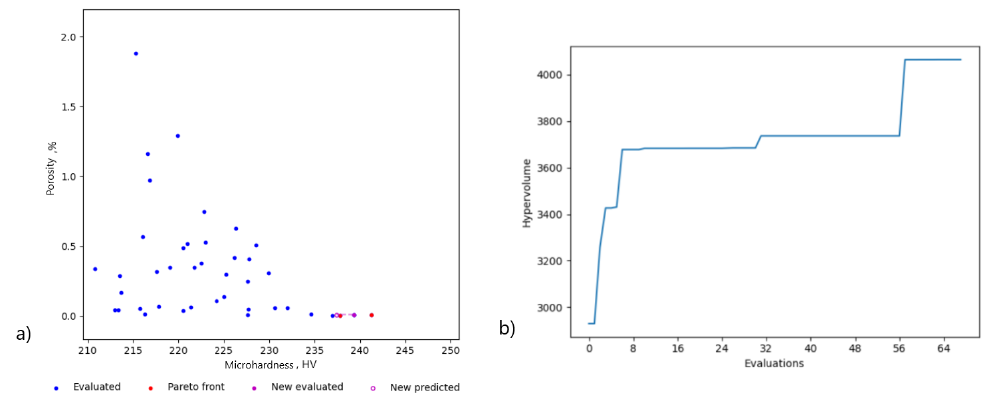
Figure 5. Performance results. ( a ) The scatter plot of the hardness versus porosity (Pareto front is colored red); open magenta marks represent candidate configuration, and solid magenta marks denote the suggested configuration after evaluation. ( b ) The hypervolume improvement plot on the right represents advancements toward the Pareto